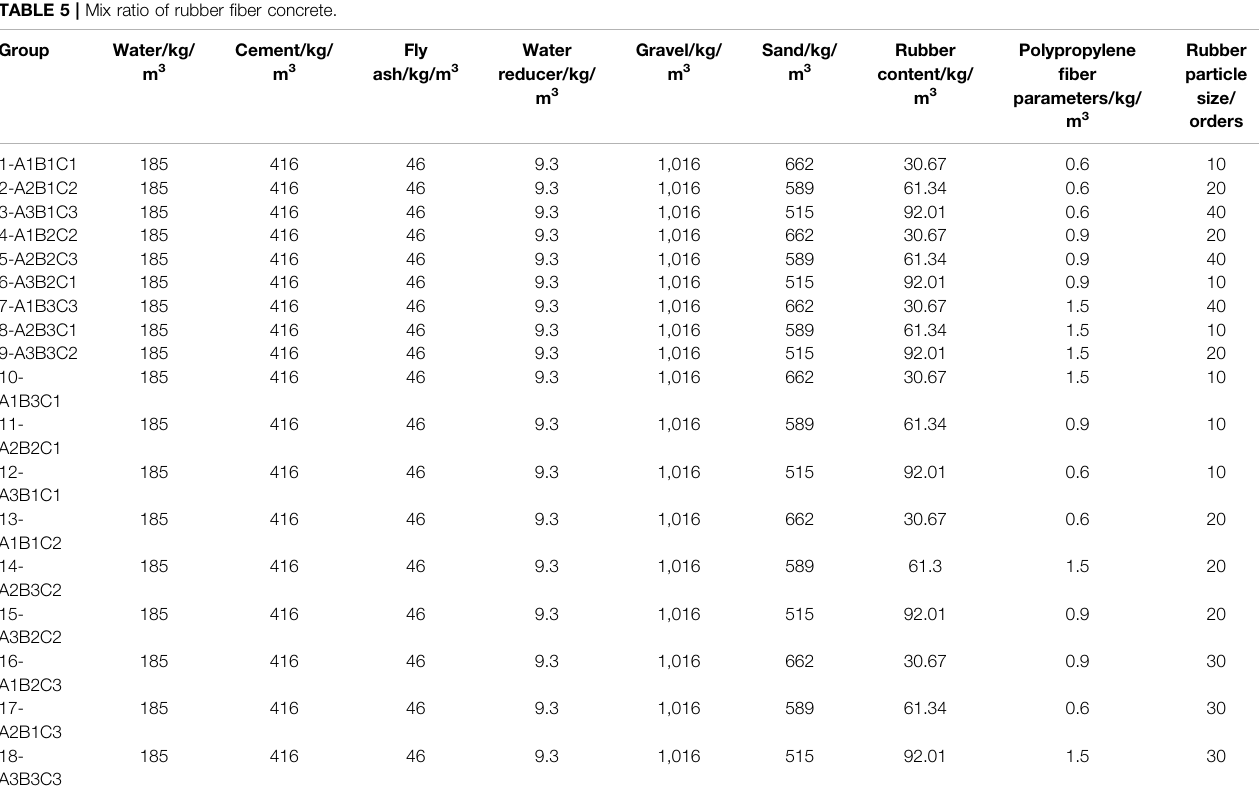
TABLE 5 | Mix ratio of rubber fi ber